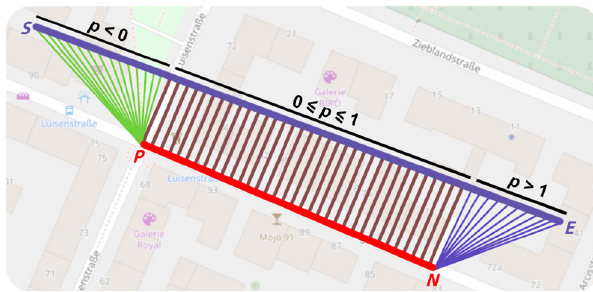
Fig. 9 Representation of C 3 for a given line segment between S and E and the current graph position P .